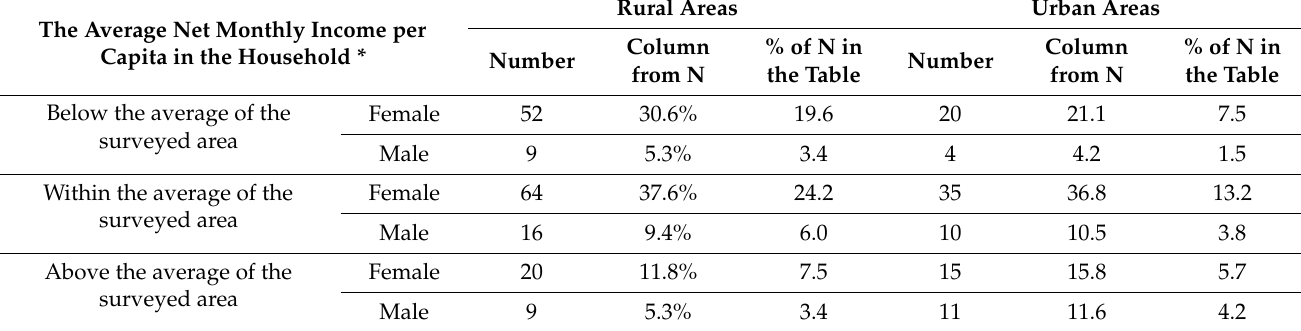
Rural Areas Urban Areas Column % of N in Column % of N in Number Number from N the Table from N the Table